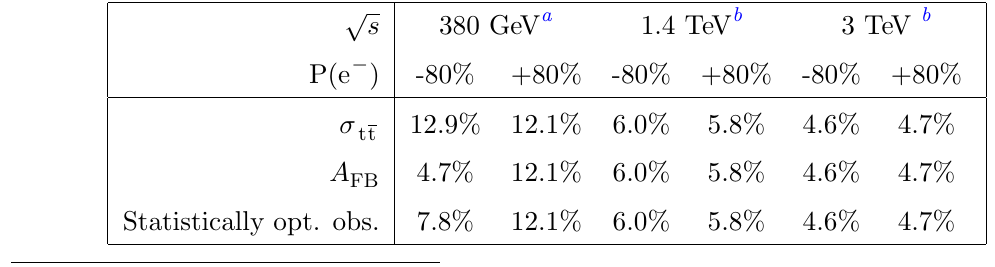
Table 17. Equivalent fractions of the theoretical e + e (cid:0) ! tt rate at the nominal centre-of-mass energies that are assumed in the EFT (cid:12)t. When multiplied by the inclusive e + e (cid:0) ! tt cross section, excluding the energy loss from ISR or beamstrahlung, and by the corresponding integrated luminosity, these fractions yield the numbers of events at (cid:12)nal level of the analyses of semi-leptonic (cid:12)nal states, as studied in full simulation at the three stages of CLIC and presented in subsection 8.2 and subsection 8.4. Di(cid:11)erent variants of the (cid:12)nal event selection are used for A of statistically optimal observables, as explained in the